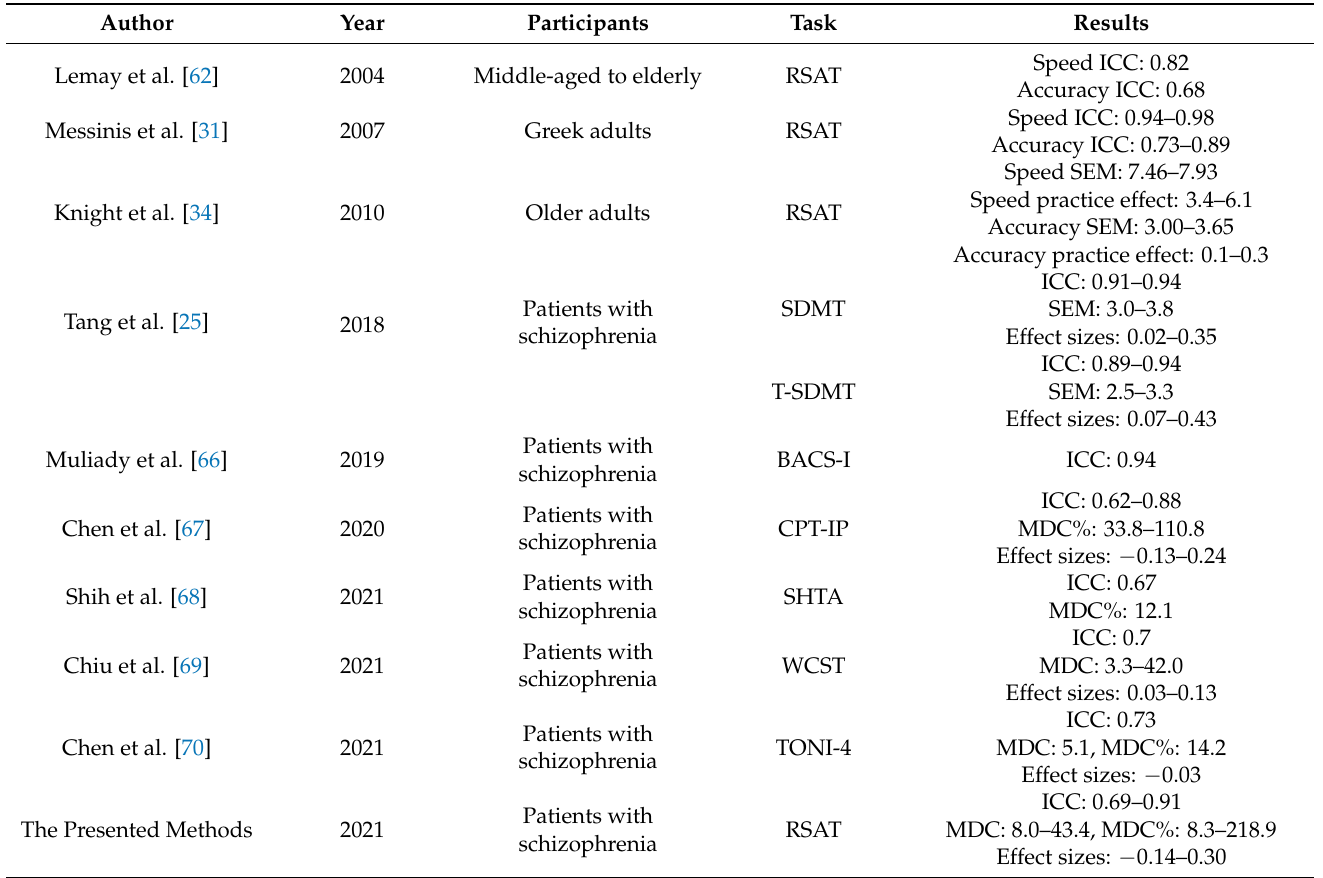
Table 3. Comparison of the proposed results with those of related